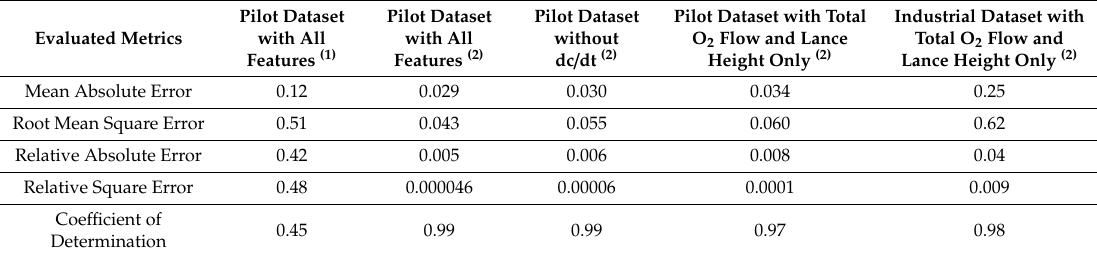
Table 3. Evaluation metrics of the predicted values of the dc / dt by using di ff erent features in the pilot dataset and using di ff erent regression